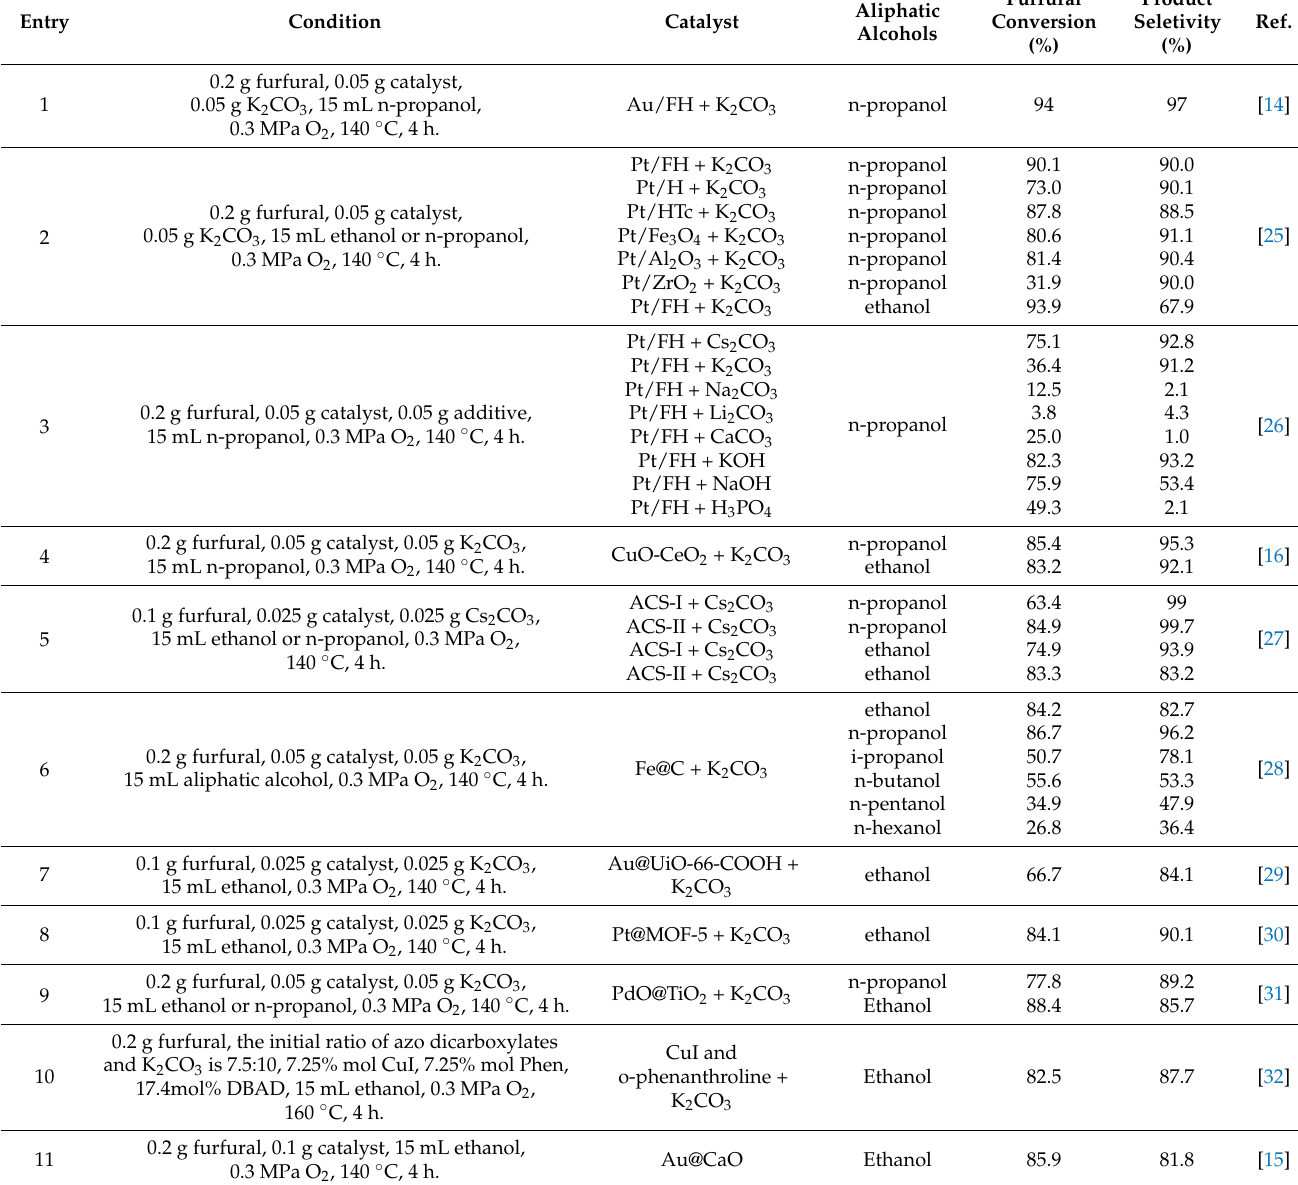
Table 3. Studies of oxidative condensation of furfural with alcohols presented by Tong’